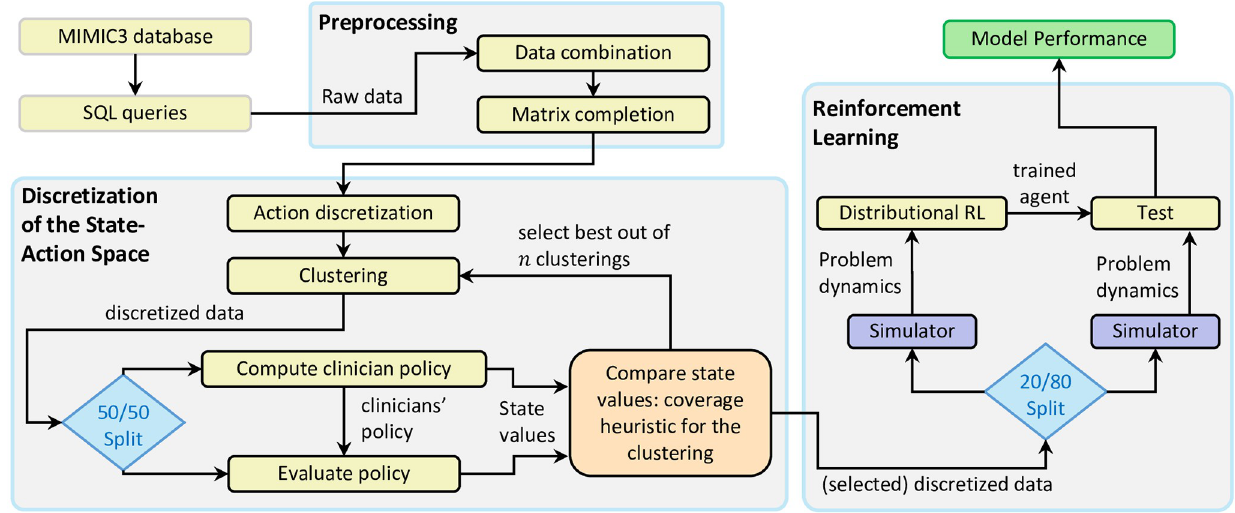
Fig 1. Overall data flow. The data flow including the three main challenges: preprocessing, state-action space representation, and reinforcement learning.